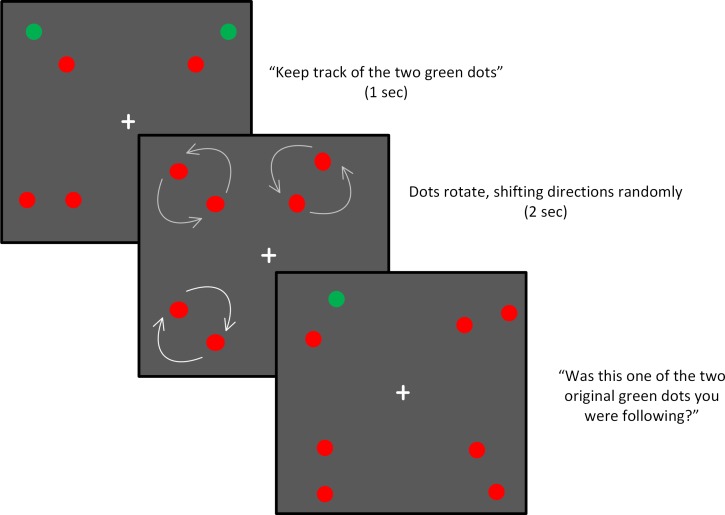
Stimuli and task for Experiment 2.In this experiment, dots rotated at a constant, moderate speed. The critical variable was the spatial arrangement of the two targets, which were placed in either the same hemifield (SH) or opposite hemifield (OH) as each other.